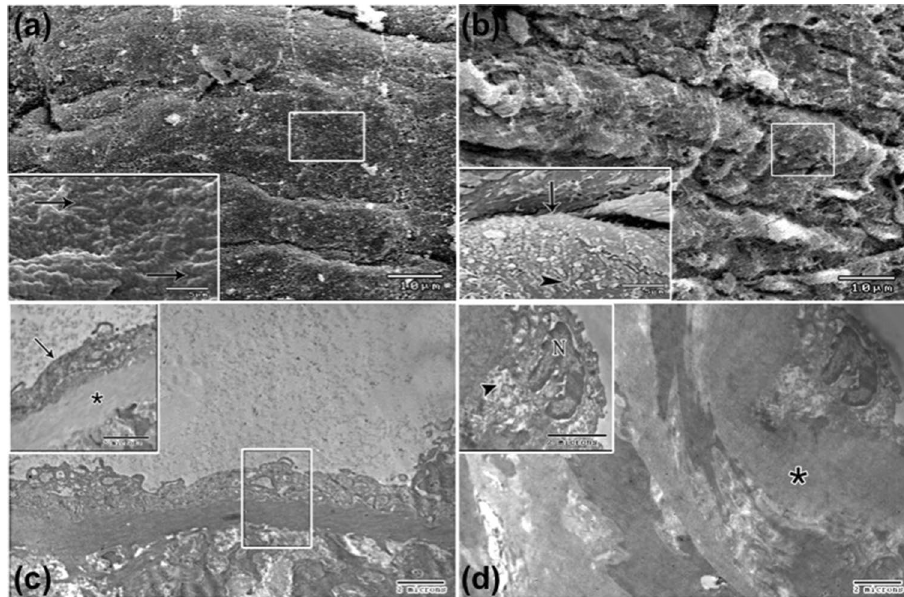
Figure 5. Scanning electron micrograph of mice aortic endothelium (×2000; insets ×5000). ( a ) Control group is showing relatively flat endothelial cells (arrows in inset). ( b ) Tramadol treated group showing raised endothelial cells (arrows in inset) with microvillus-like projections are apparent projecting from the luminal membranes (arrowheads in inset). Notice: white square indicates the area of magnification. Transmission electron micrographs of mice aortic endothelium (×4800; insets ×7200) showing ( c ) the luminal surface of a control group consisting of a single layer of endothelial cells (arrow in inset) in alignment with the internal elastic lamina (asterisk in inset). Notice: white square indicates the area of magnification. ( d ) Irregular alinement of endothelial cells with irregular internal elastic lamina (asterisk) are seen in tramadol treated group. The endothelial cell has an irregular shape nucleus (N) and rarified cytoplasm (arrowhead in